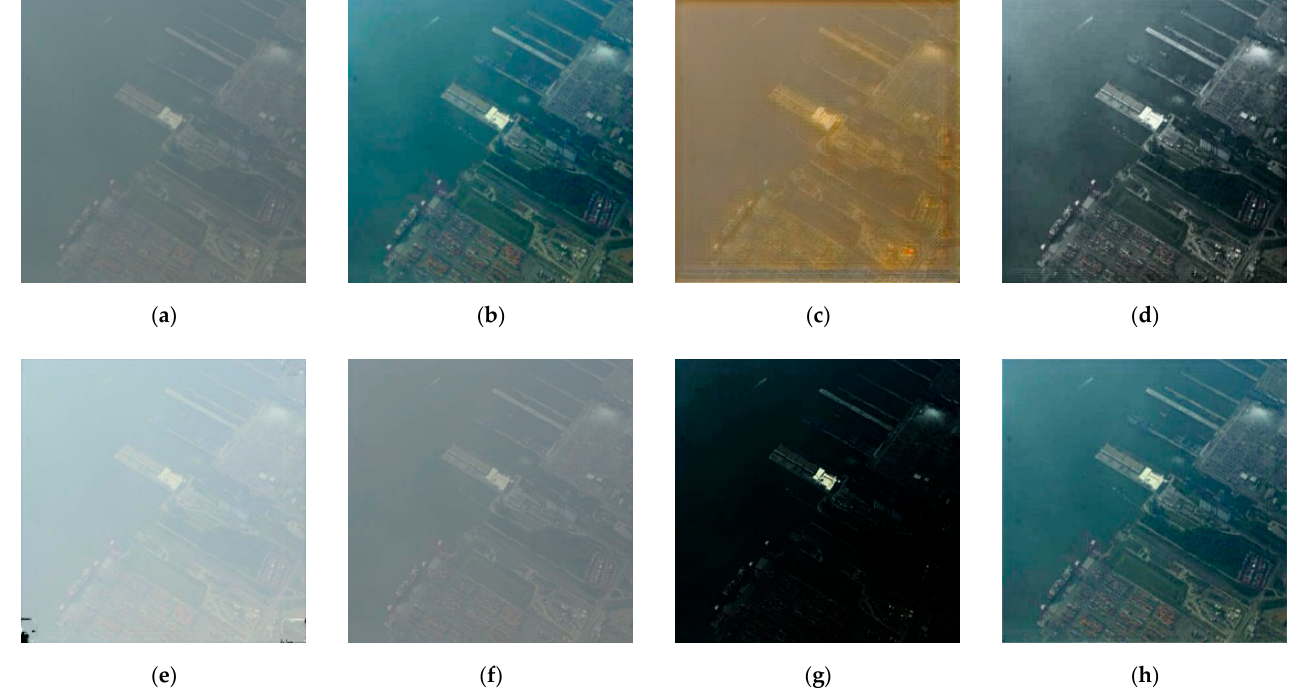
Figure 10. Foggy image #2: ( a ) input, ( b ) target, ( c ) CycleGAN, ( d ) Lum CycleGAN, ( e ) EV GAN, ( f ) HDRCNN, ( g ) ExpandNet, and ( h ) the proposed